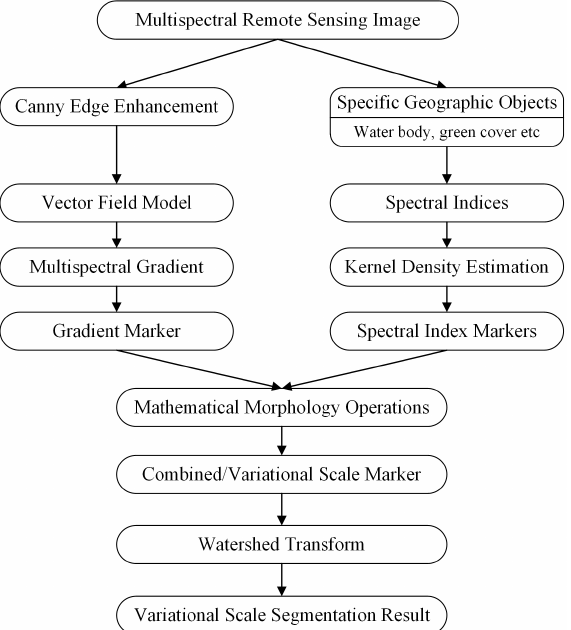
Figure 2. Flow chart of the proposed auto-marker watershed transform image segmentation based on spectral indices and gradient